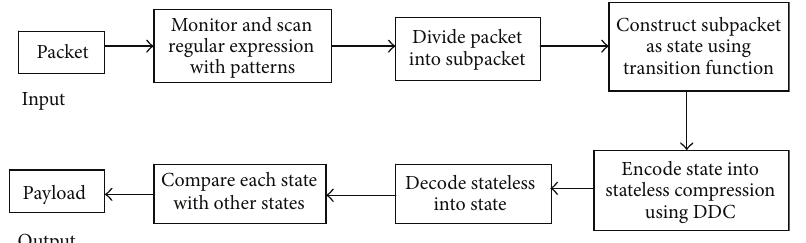
Figure 1: Proposed flow for pattern payload